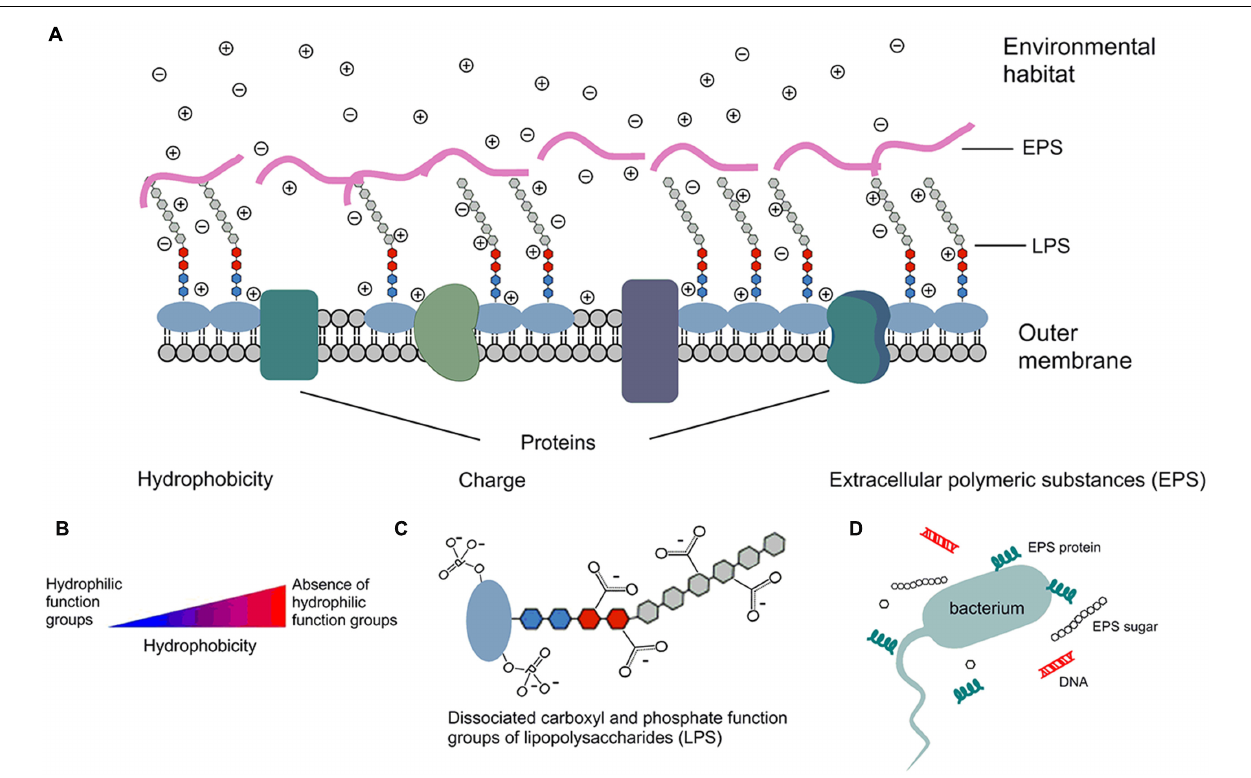
FIGURE 1 | Schematic depiction of E. coli surface properties. ⊕ cation in solution; (cid:9) anion in solution; − negative charge due to dissociation. (A) E. coli outer membrane has several components that contribute to cell surface properties, such as hydrophobicity, surface charge, zeta potential, and components of extracellular polymeric substance (EPS). (B) Cells that are absence of hydrophilic function groups are more hydrophobic than cells with hydrophilic function groups. (C) Surface is negatively charged due to the dissociation of carboxylic acid and phosphate functional groups; similar dissociation can also occur on the EPS and phospholipids of the membrane. Therefore, more cations than anions exist in solution, and that separation of charge is measured by the zeta potential. (D) EPS are mainly composed of sugars and proteins, but they may also include other macromolecules such as